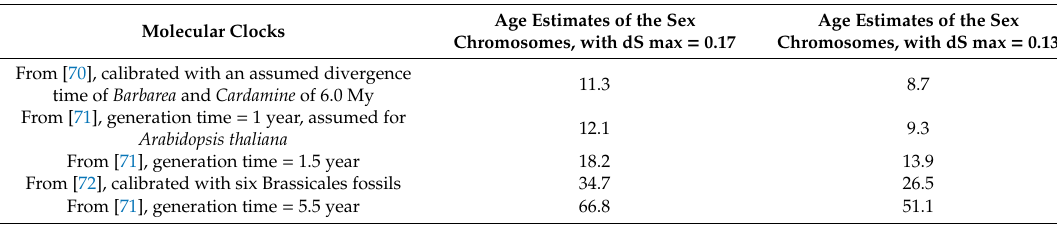
Table 3. Age estimates of the C. grandis XY system. These estimates were obtained using the maximum synonymous divergence between X and Y chromosomes and several molecular clocks from Brassicaceae. Estimates are shown in increasing order. Age Estimates of the Sex Age Estimates of the Sex Molecular Clocks Chromosomes, with dS max = 0.17 Chromosomes, with dS max = 0.13 From [70], calibrated with an assumed divergence time of Barbarea and Cardamine of 6.0